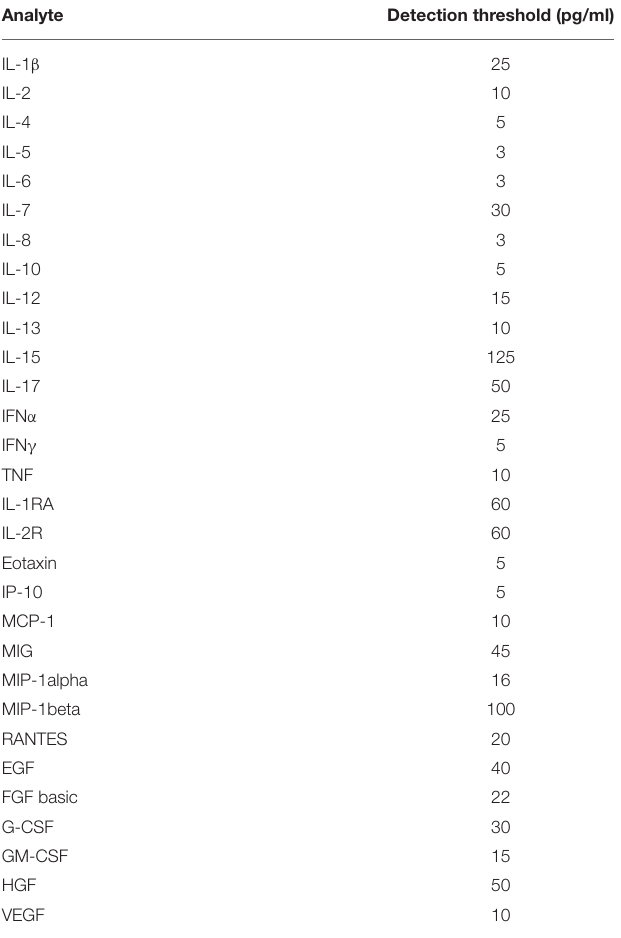
TABLE 1 | Proteins analyzed by multiplex assay and their detection